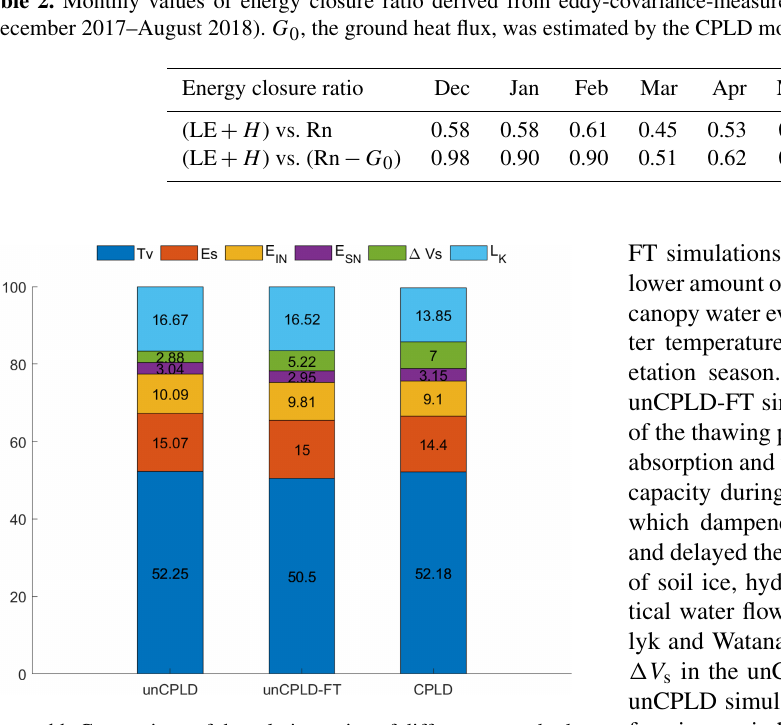
Figure 11. Comparison of the relative ratios of different water bud- get components to precipitation during the whole simulation period produced by different model scenarios. T v is transpiration, E s is surface evaporation, E IN and E SN are evaporation from intercepted canopy water and snow cover, (cid:49) V s is changes in soil water storage, and L K is deep leakage